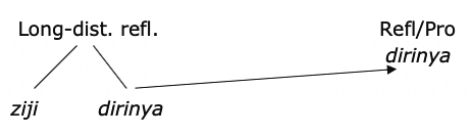
Figure 4: Eliminating variants (Singapore Malay